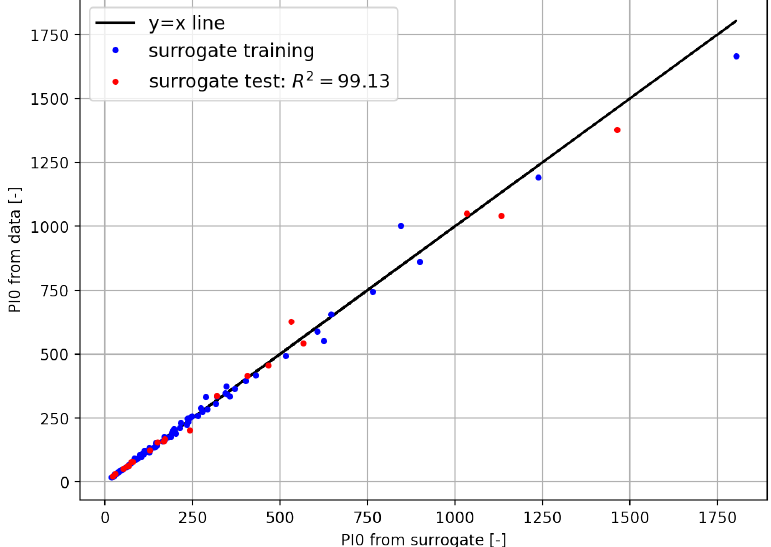
Figure 19. Surrogate model for single actuator housing: π 0 results (Equation